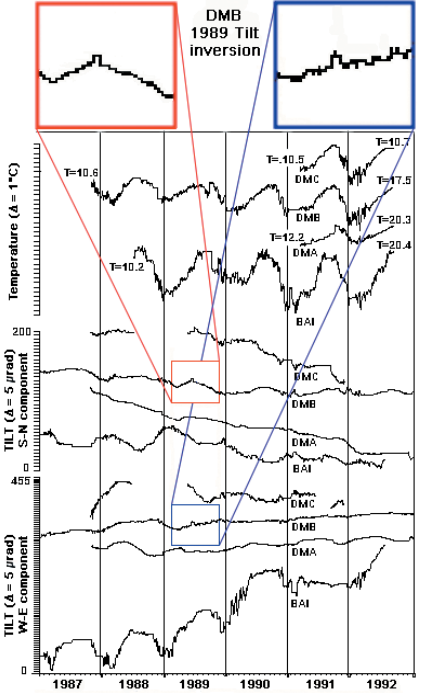
Fig. 11. Ground Tilt and Te recorded by the network OV-IPG in the period 1987-1992: every signal includes more than 100.000 data points with sample rate of 1 cph. The zoomed windows concern the uplift phase. Tilt decrease must be interpreted as sinking (southward and westward down) otherwise as